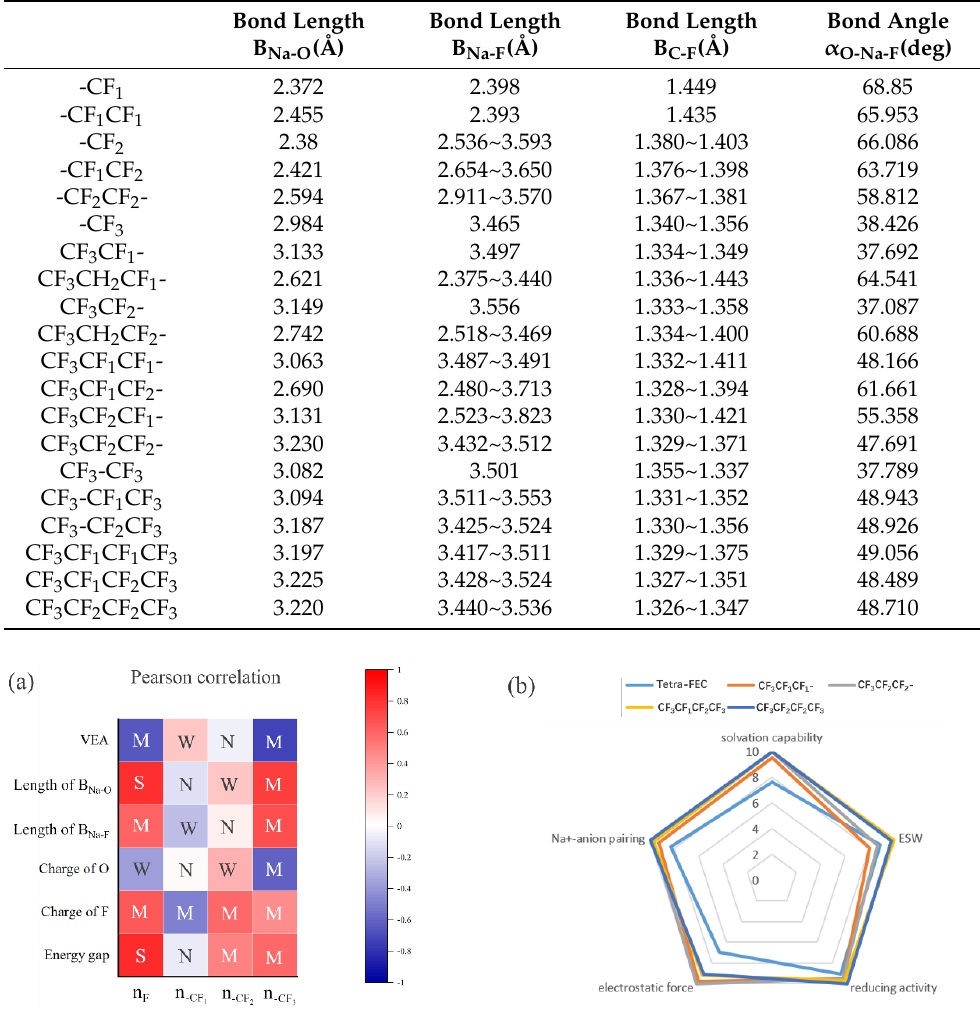
Figure 5. Pearson correlation analysis implemented in the heat map ( a ). Radar plot evaluating five solvents. The ratings between 1 and 10 are given according to the measured performance of each solvent. A rating of 10 represents strongest solvation capability, largest ESW, highest reductive activity, least electrostatic force, and strongest Na-anion pairing, whereas 0 denotes the opposite ( b ). Combined with the previous discussion on fluorination sites, -CF 1 and -CF 2